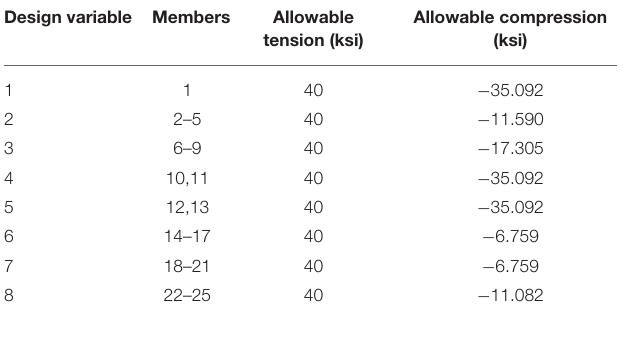
TABLE 3 | 25-bar space truss: allowable stresses for each design group.